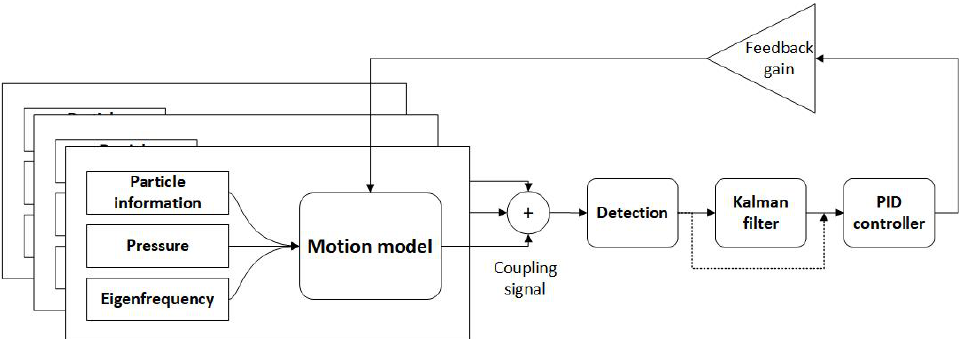
Figure 3. The optical trap simulation model includes motion, detection and feedback cooling modules.